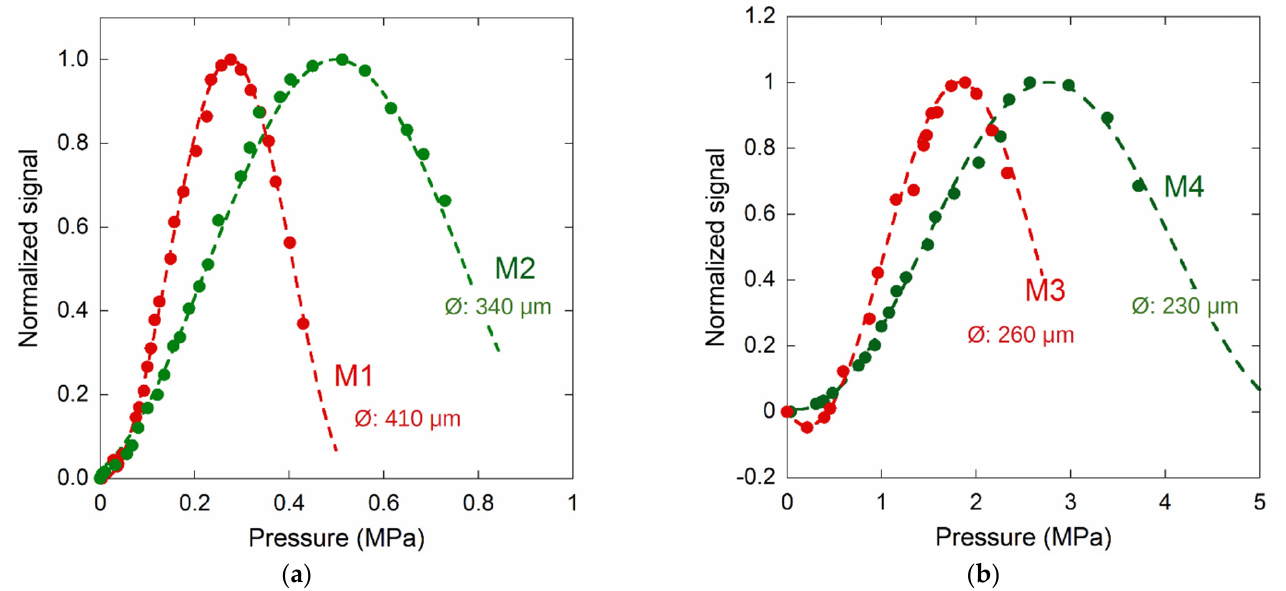
Figure 11. Normalized photocurrent signal induced by light wave interference for different diamond membranes (see text). Experimental results for M1 and M2, in ( a ), and for M3 and M4, in ( b ), membranes. See table 1 for details.